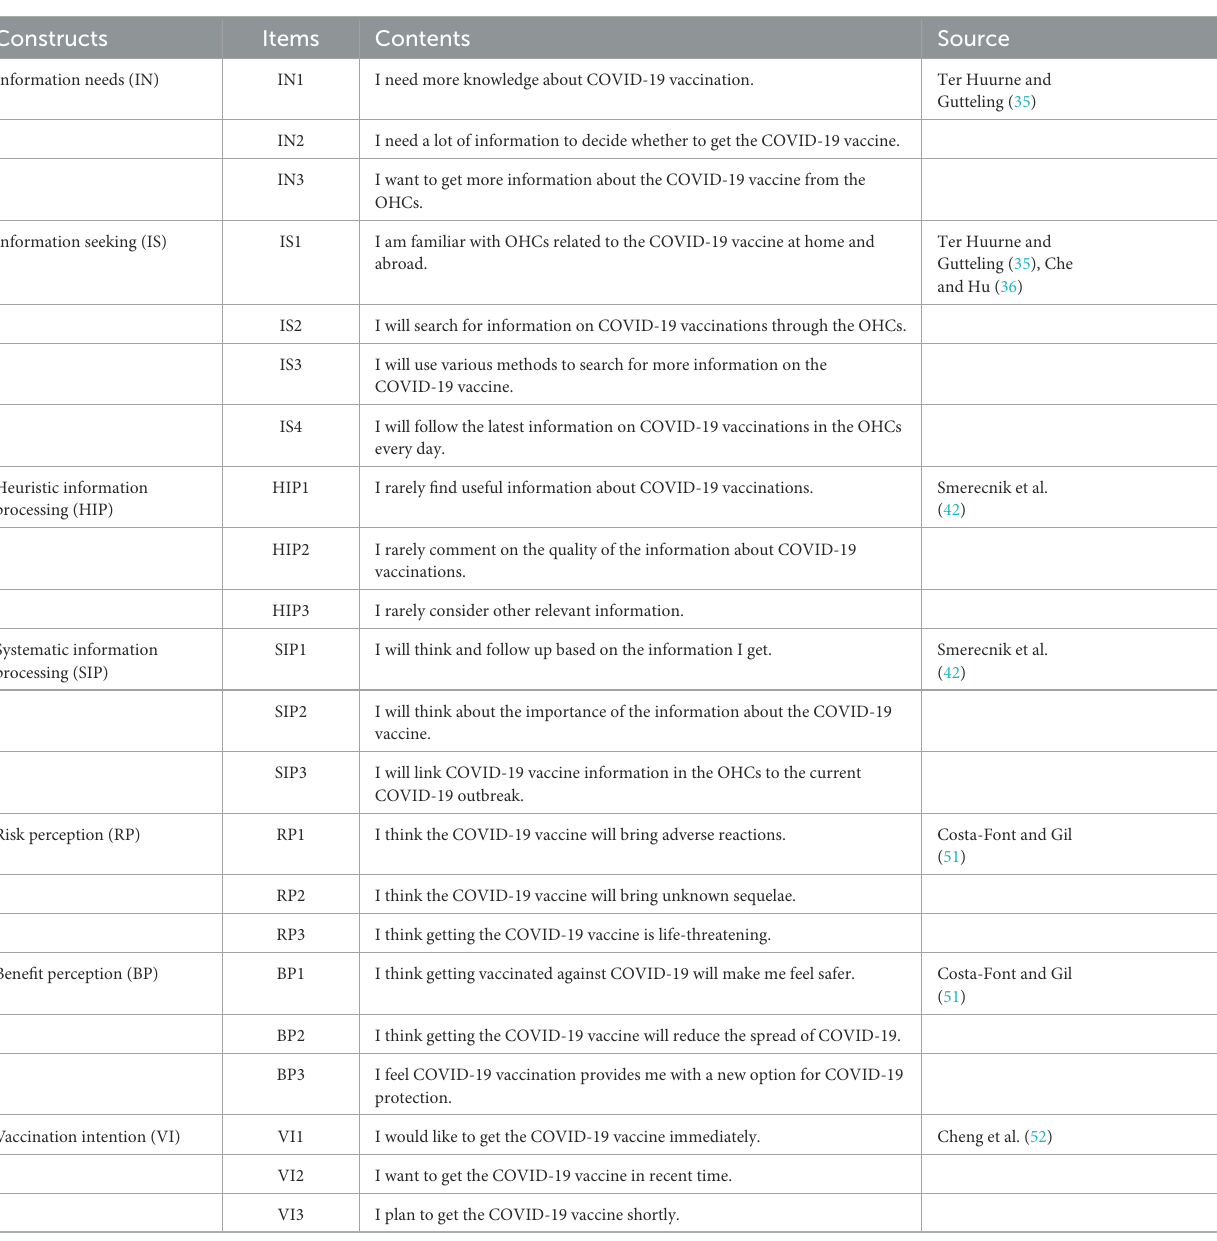
TABLE 1 Constructs and measurement